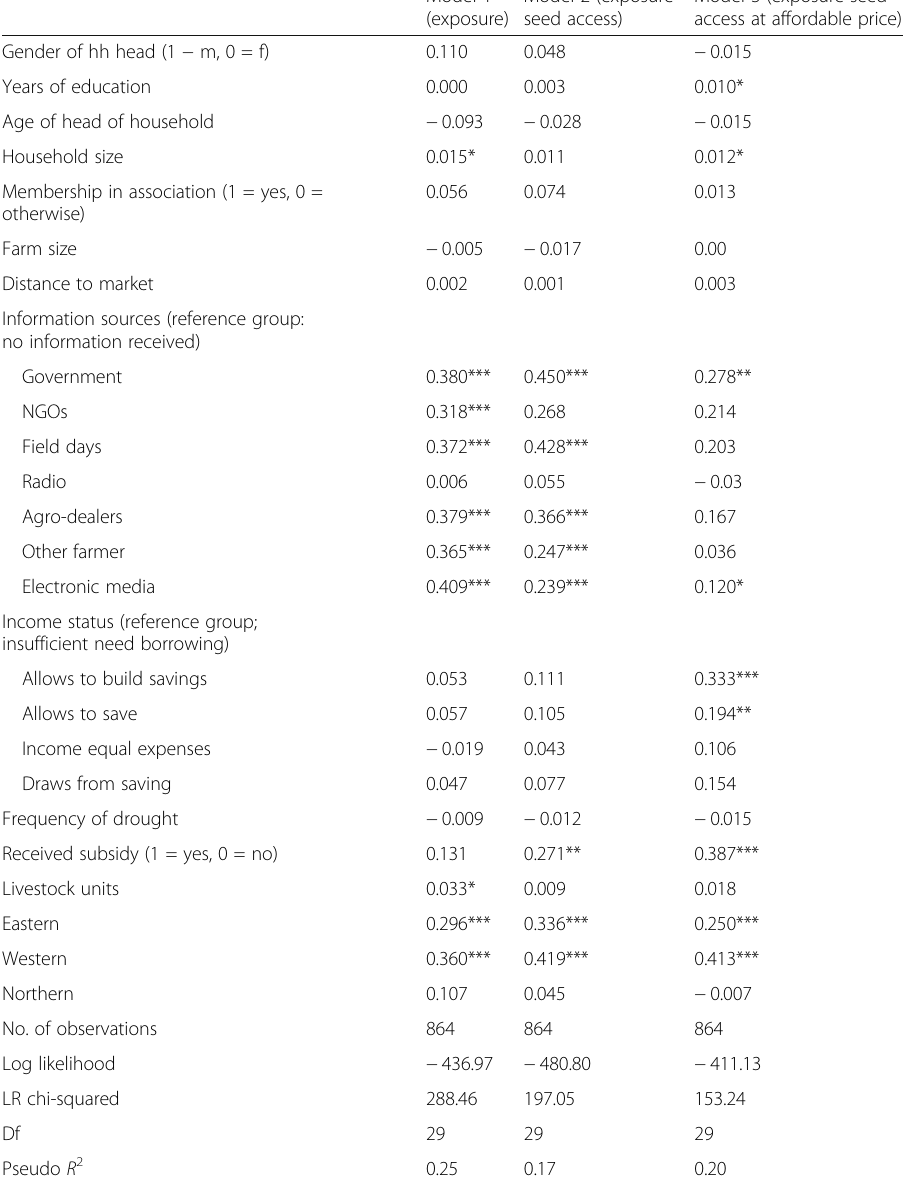
Table 3 Probit estimates of the determinants of exposure, access and affordability of DTMV seed